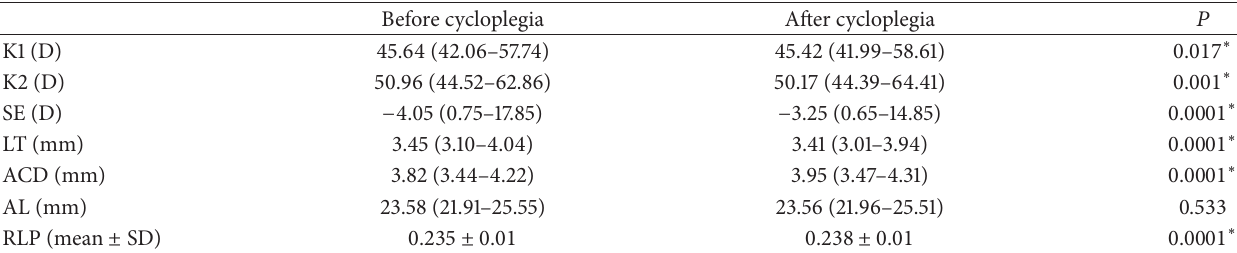
Table 1: Response to cycloplegia in Group 1 ( 𝑛 = 48